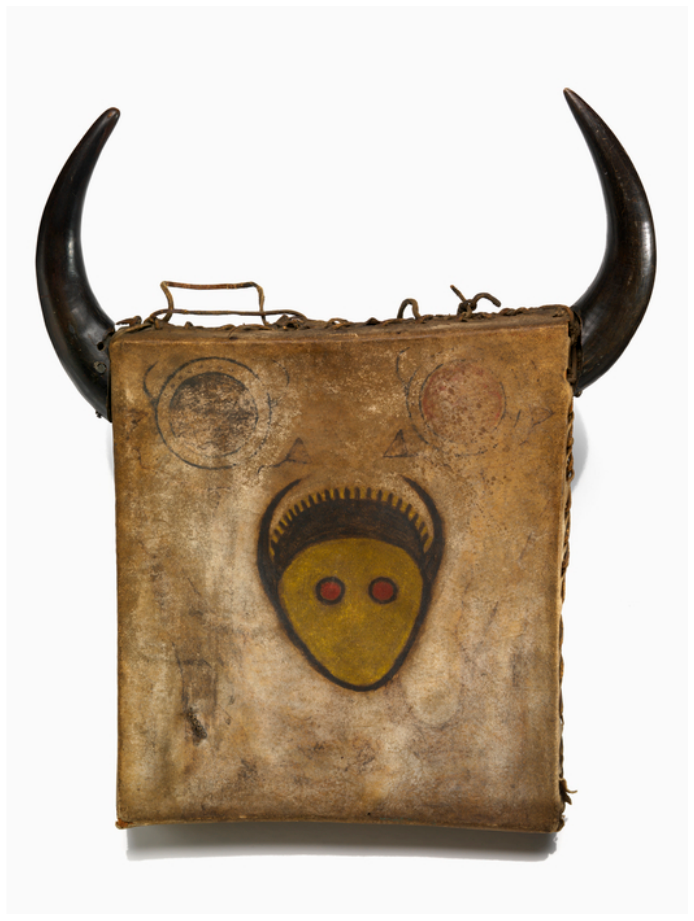
Figure 1. Hand Drum, Attributed to Siyosapa (Hunkpapa/Yanktonai), Collected during the mid-1870s, wood, rawhide, buffalo horn, paint, hide thong, 59 cm × 49 cm × 7 cm. Used by permission of the National Museum of the American Indian, Smithsonian Institution (232202). Photo by NMAI Photo Services.